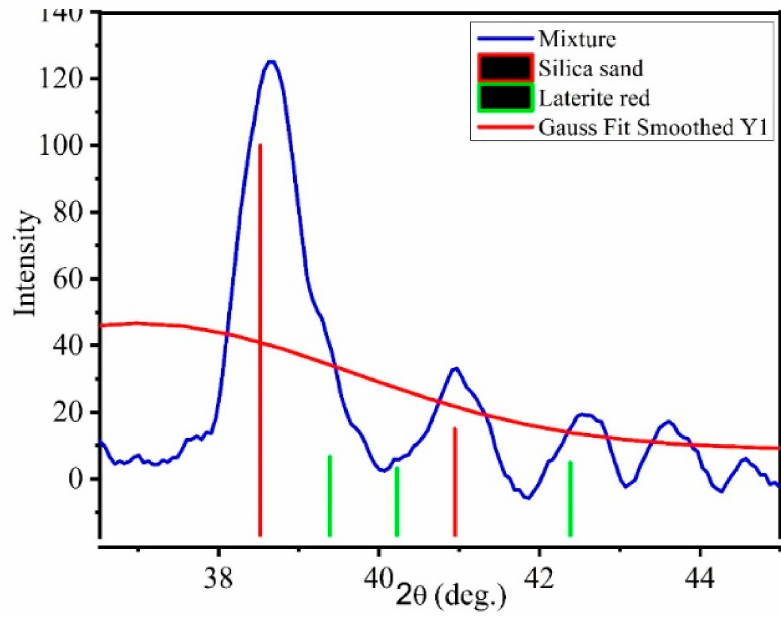
Figure 20. Gaussian fitting of laterite red and silica sand.